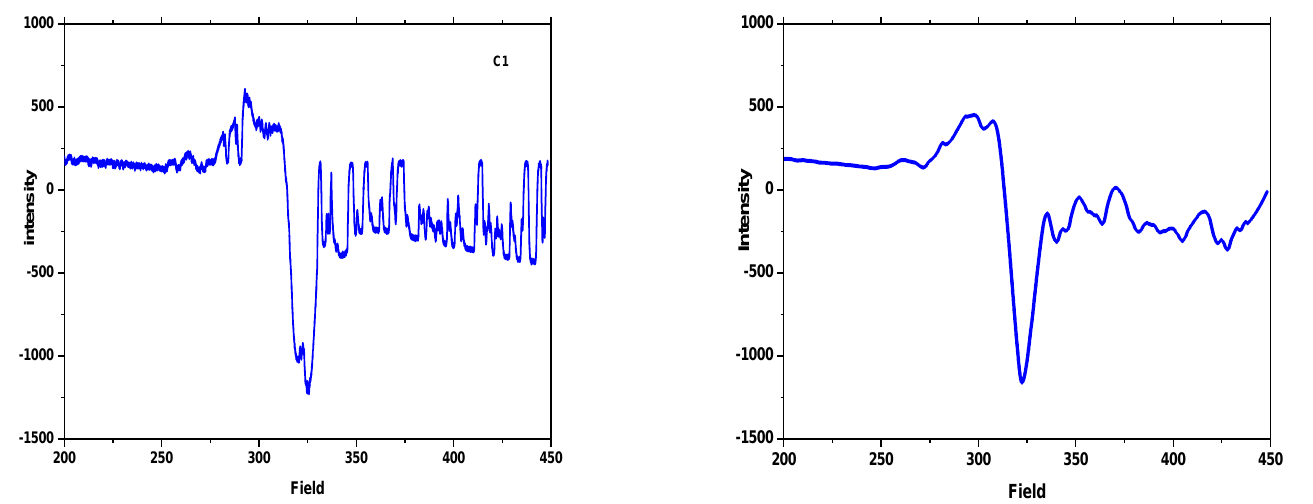
Figure 3. ESR Spectra of C1 ( right ) and C2 ( left ) complexes.